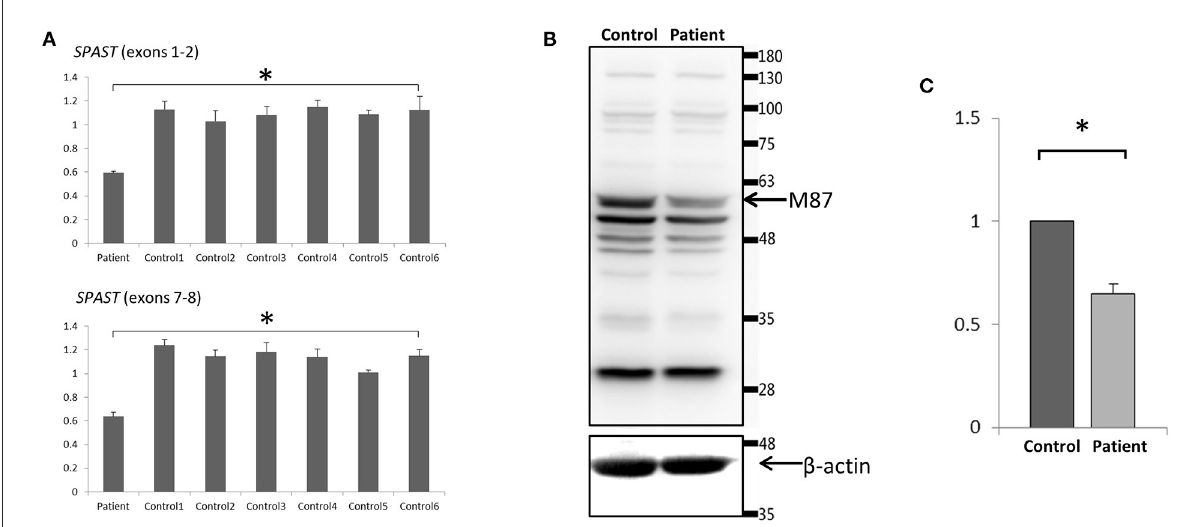
FIGURE4 Expression analysis of spastin in lymphoblast cell lines. (A) Quantitative PCR of SPAST cRNA showed a ∼ 50% decrease standardized against 18SRNA in the proband compared with 6 wild-type controls. Data were the mean ( ± SD) of three independent experiments, Mann-Whitney U test; * p < 0.01. (B) Western Blotting analysis revealed a decreased level of the spastin protein in the patient compared to the control. Blots are representative images from 3 independent experiments. (C) Densitometry analysis of the peak density normalized over β -actin showed a ∼ 40% decrease of spastin protein in the patient compared with the control. Data were the mean ( ± SD) of three independent experiments, * P < 0.05. The Mann-Whitney test was used to compare the two